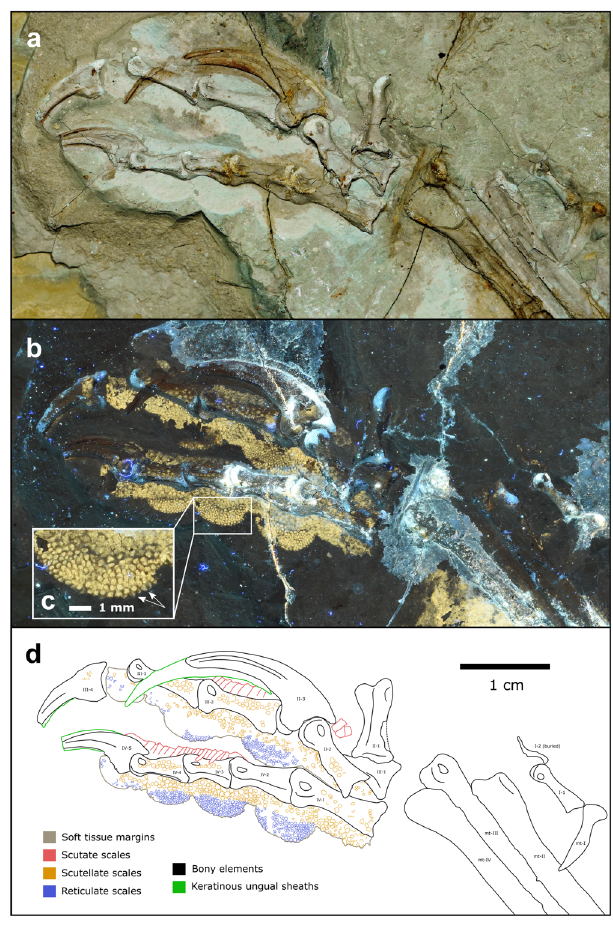
Fig. 2 | Near-complete, semi-articulated right pes of Microraptor STM 5-109. Fossil under a white light and b laser-stimulated fl uorescence. c Close-up of reti- culate and scutellate scales on digit IV, with arrows indicating exemplary spiculate reticulate scales. d Interpretive drawing, where solid lines indicate preserved structural boundaries, and dashed lines represent assumed or completed bound- aries.Notethearthralarrangementoftoepadsinwhichtheinterpadcreasesdonot align with the phalangeal